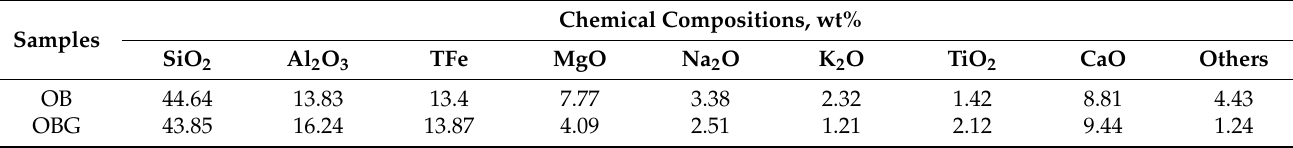
Table 1. Chemical compositions of the OB and OBG